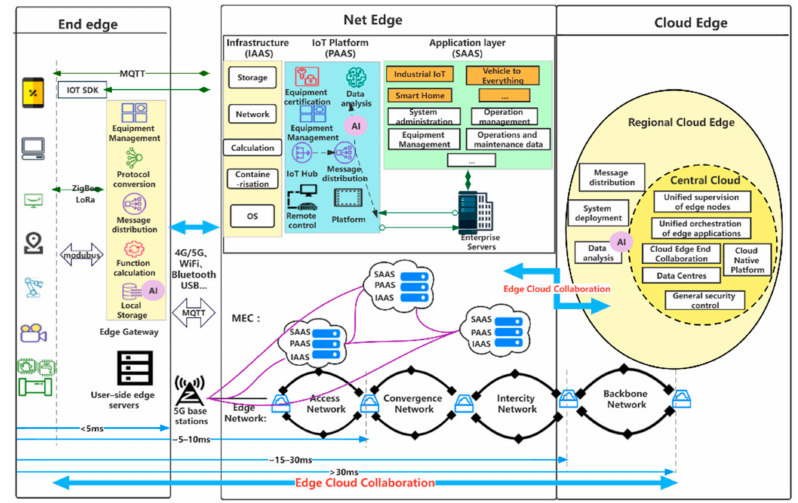
Figure 2. IoT Edge Computing Reference